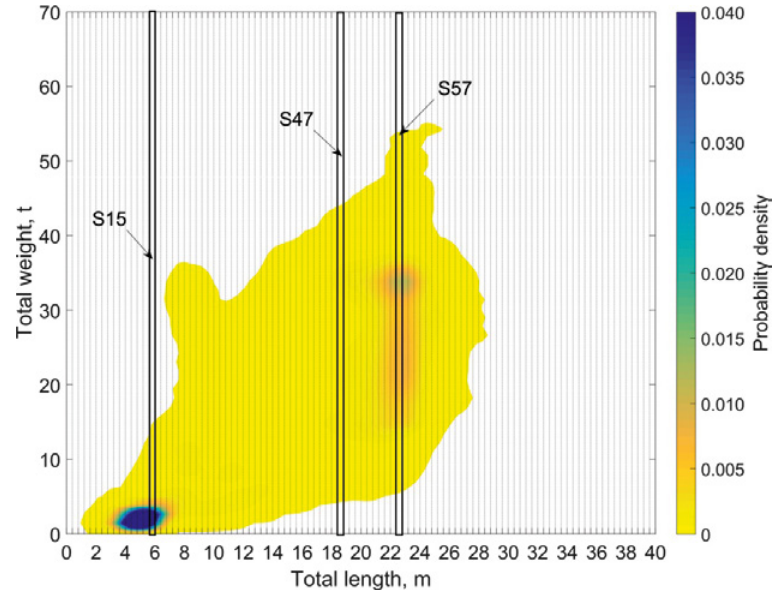
Figure 3. Vehicle length-weight